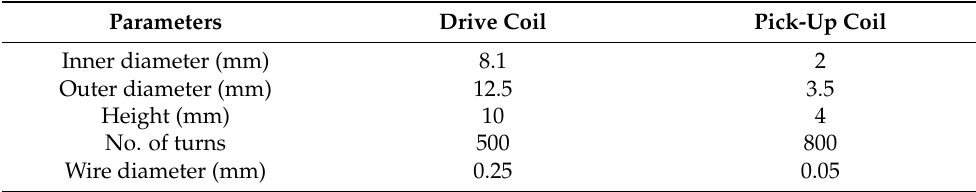
Table 2. Parameters of the probe